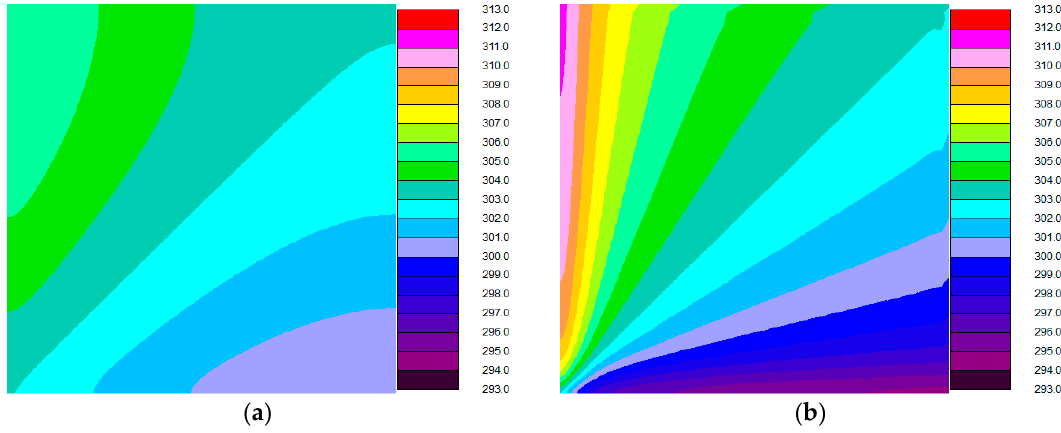
Figure 8. The plate temperature distributions of cross-flow plate heat exchanger ( a ) Heat transfer model with LHC; ( b ) Heat transfer model without LHC.